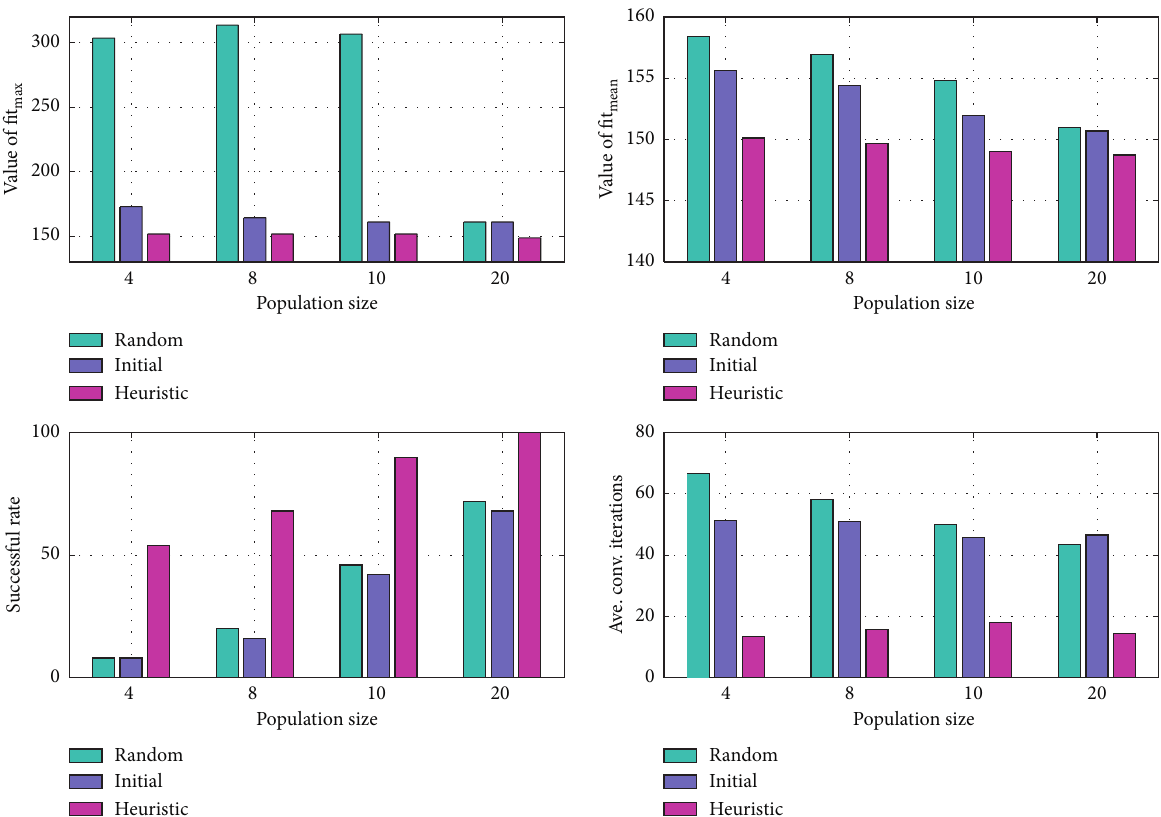
Figure 7: Comparisons among three initialization methods in terms of fit ) for the 33-node iterations ( G mean